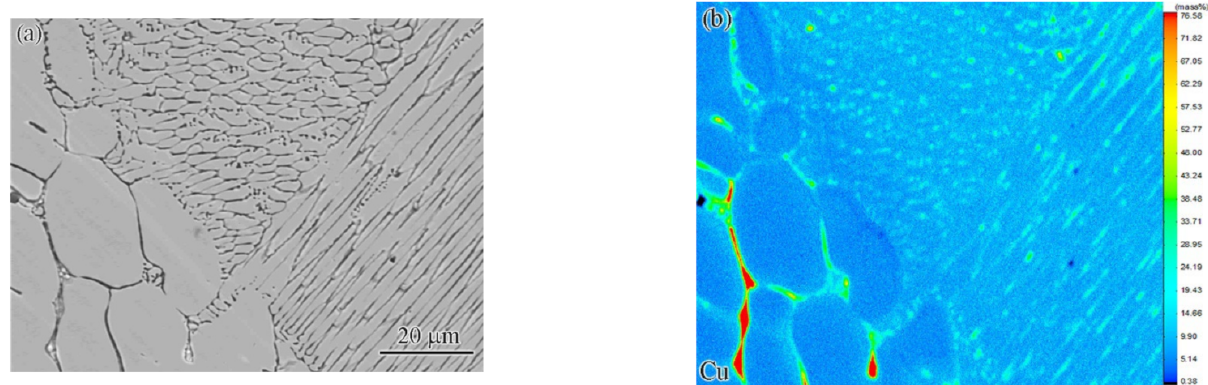
Figure 8. EMPA compositional mapping of Cu at a laser power of 1.85 kW: ( a ) micro-morphology and ( b ) element distribution of